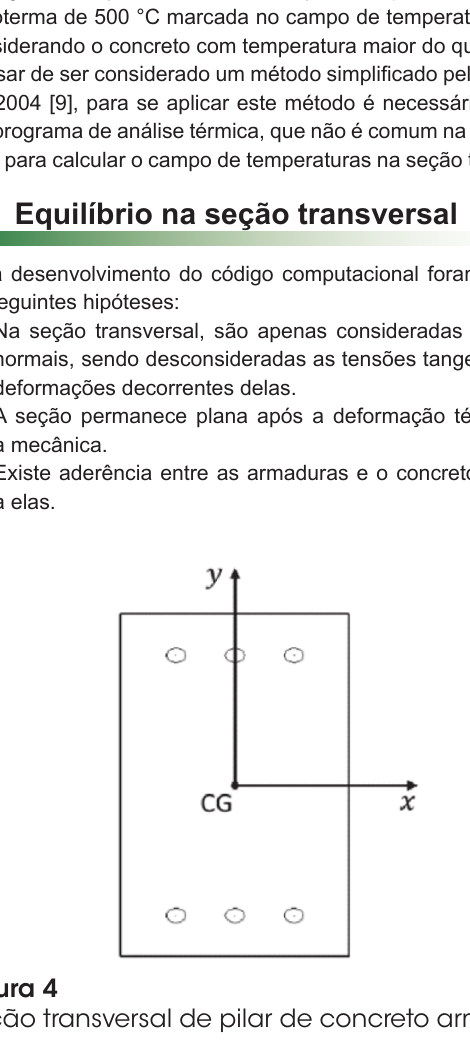
Seção transversal discretizada com o campo de temperaturas mostrando a isoterma de 500 °C Na Figura 3, é apresentado um exemplo de seção transversal com a isoterma de 500 °C marcada no campo de temperaturas e des-